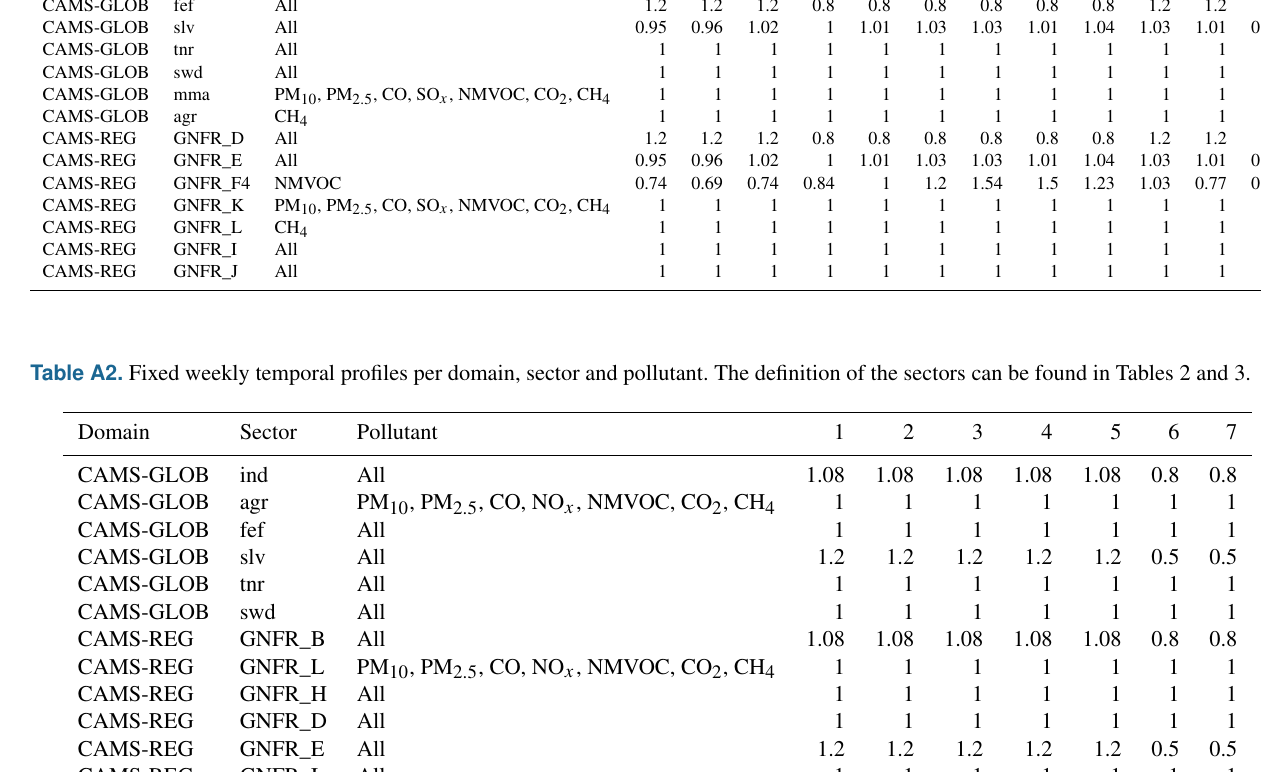
Table A1. Fixed monthly temporal profiles per domain, sector and pollutant. The definition of the sectors can be found in Tables 2 and 3. Domain